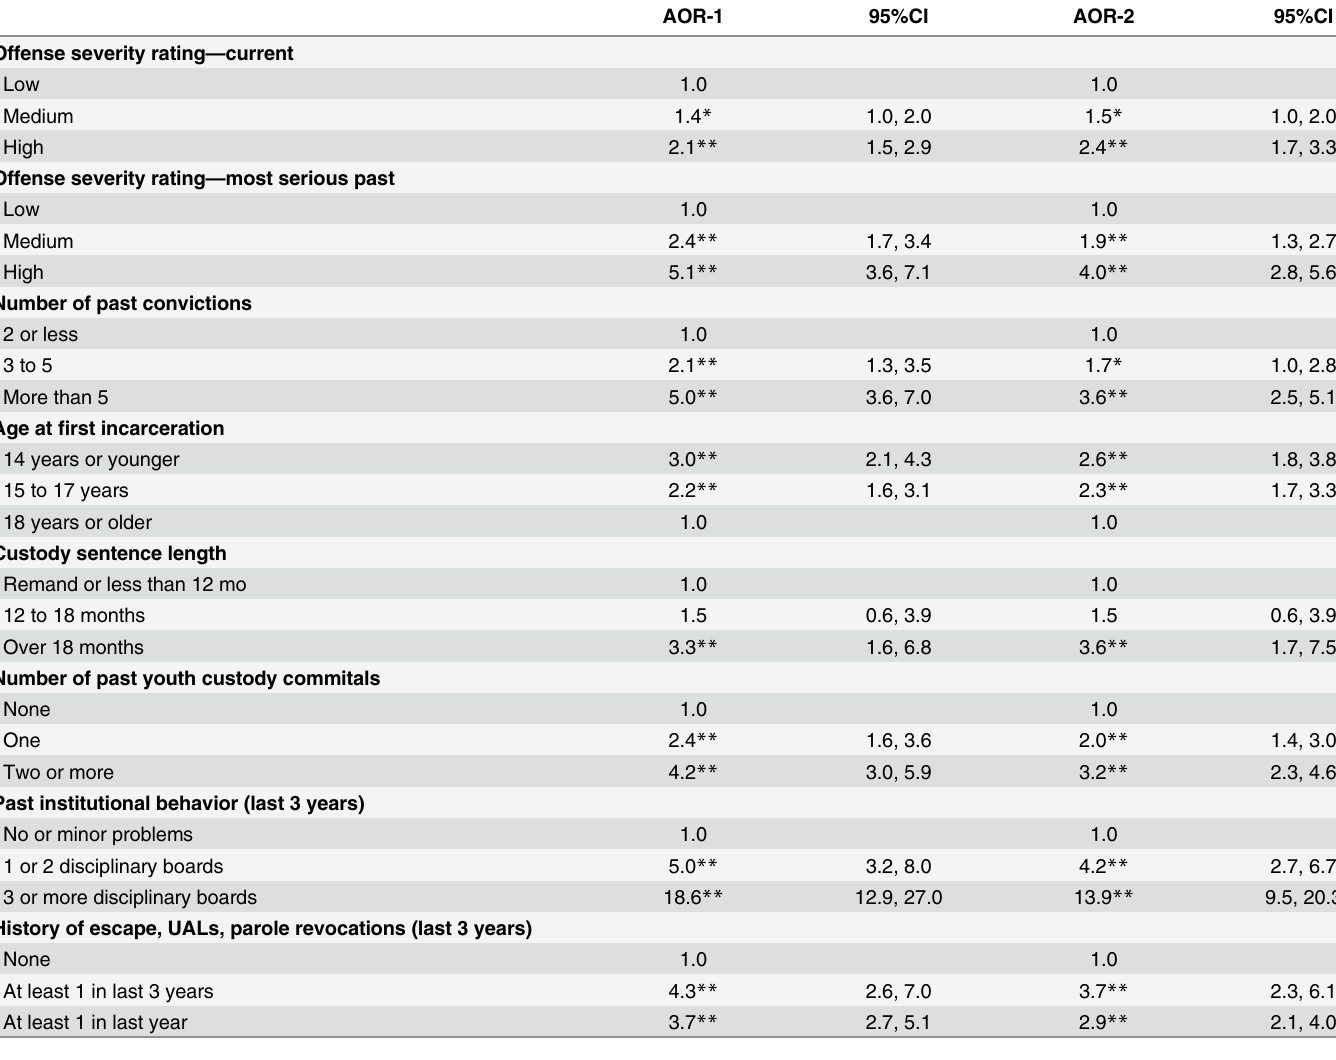
Table 2. Offense-related correlates of self-harm during most recent